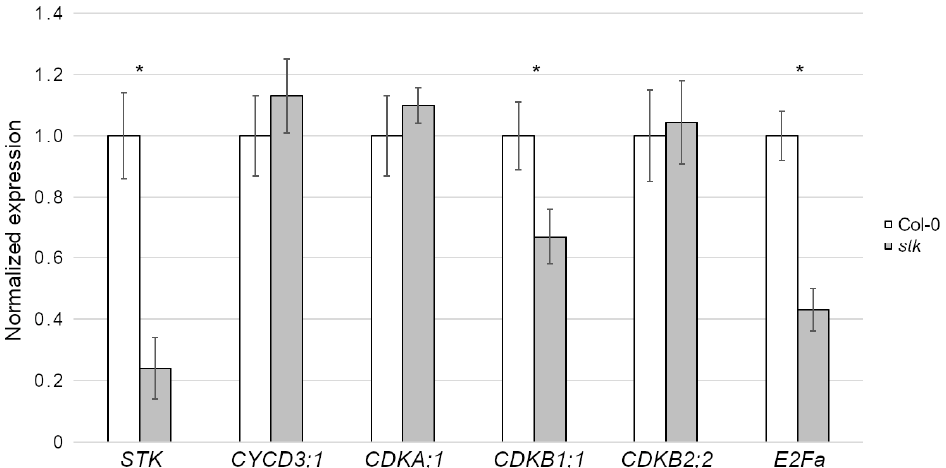
Figure 2. Expression level of cell cycle regulators in Col-0 and stk mutants. The q-PCR was conducted in triplicates using ACTIN ( ACT ) and UBIQUITIN ( UBQ ) as internal reference genes (Supplementary Table S1). Error bars represent the propagated standard deviation error value using three replicates; asterisks represent statistically significant differences ( p <